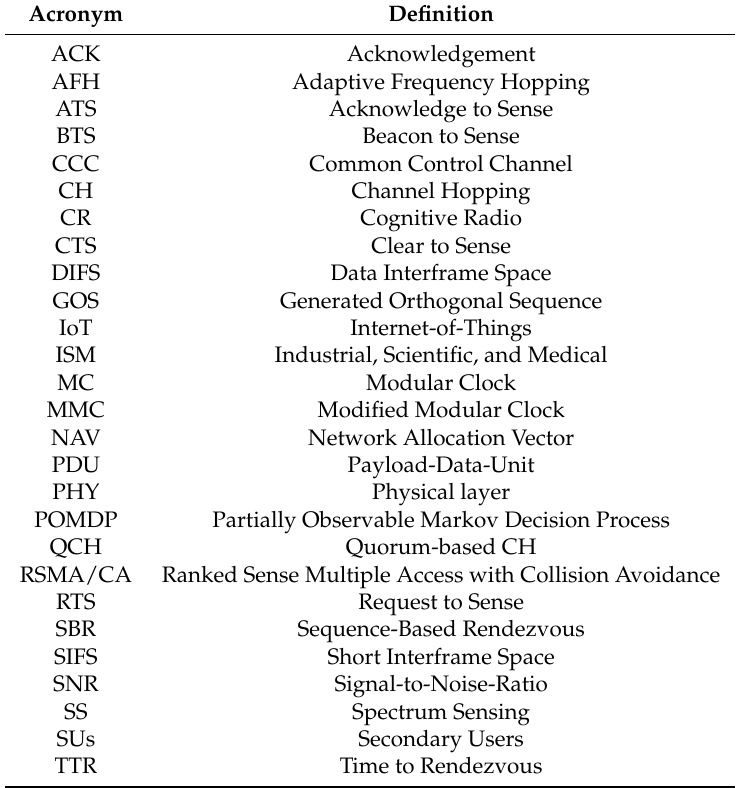
Table 1. Summary of the